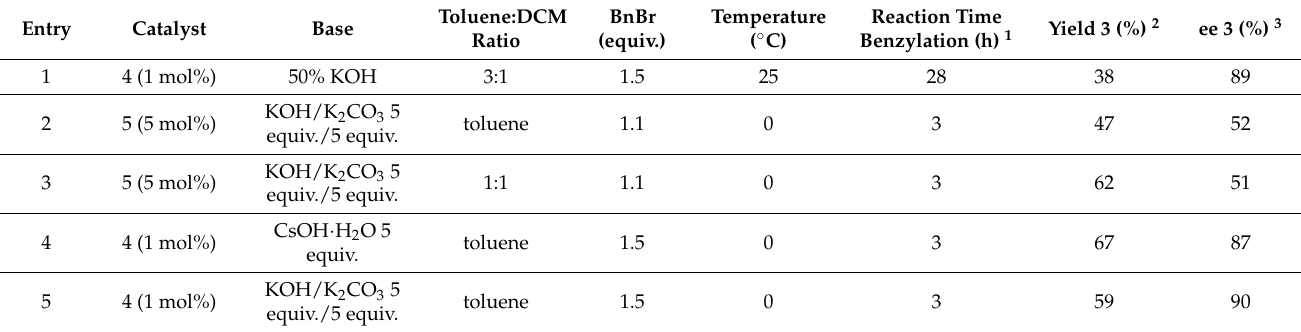
Figure 1. Phase transfer model reaction for continuous flow methodology. Table 1. Preliminary experiments in